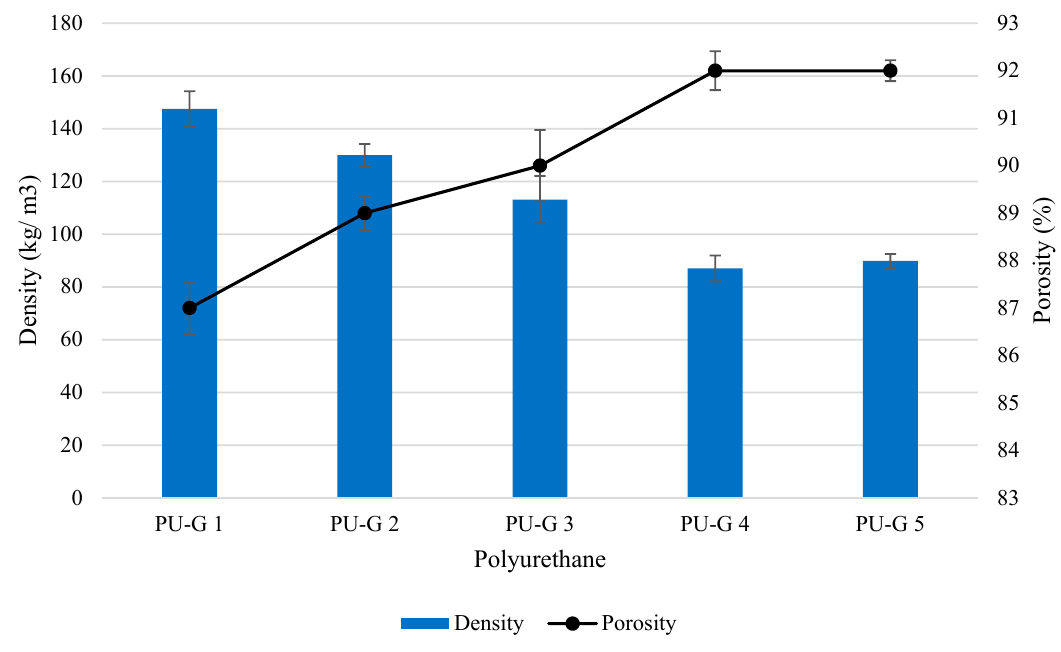
Figure 2. Density and porosity of polyurethanes produced by different water content of 0.6 g (PU-G 1), 0.8 g (PU-G 2), 1.0 g (PU-G 3), 1.2 g (PU-G 4) and 1.4 g (PU-G 5) (Mean ± SD, n = 3).